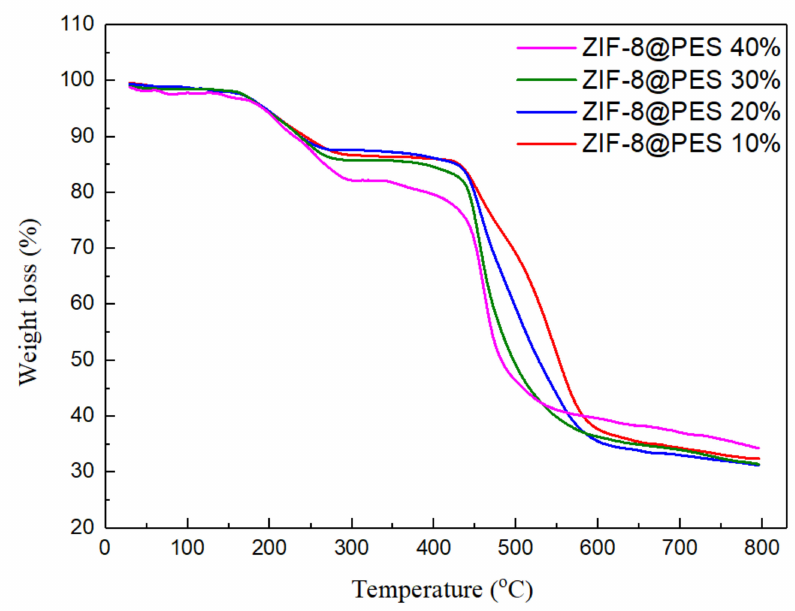
Figure 9. TGA curve of prepared MMMs at di ff erent mixing ratios of